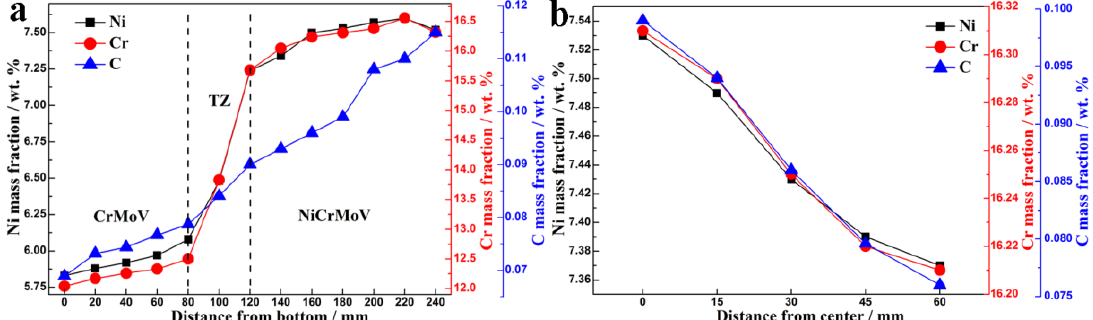
Figure 4. Ni, Cr, and C concentration distributions along ( a ) the longitudinal centerline and ( b ) the transverse radius in the ESR ingot.